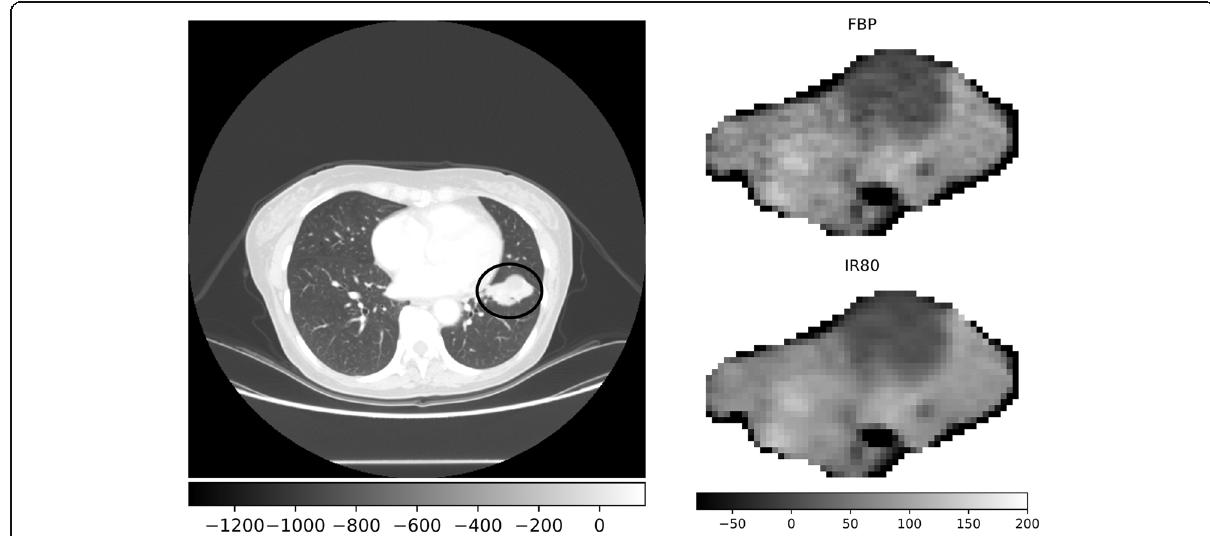
Fig. 1 Visual comparison of computed tomography images of the same patient reconstructed with two blending levels. The image on the left shows the thorax of the patient with the encircled lesion, displayed using the lung window. The same lesion is isolated in the right figures, displaying the filtered backprojection (FBP) reconstruction and the iterative algorithm with ASIR 80% (IR80) with a mediastinal